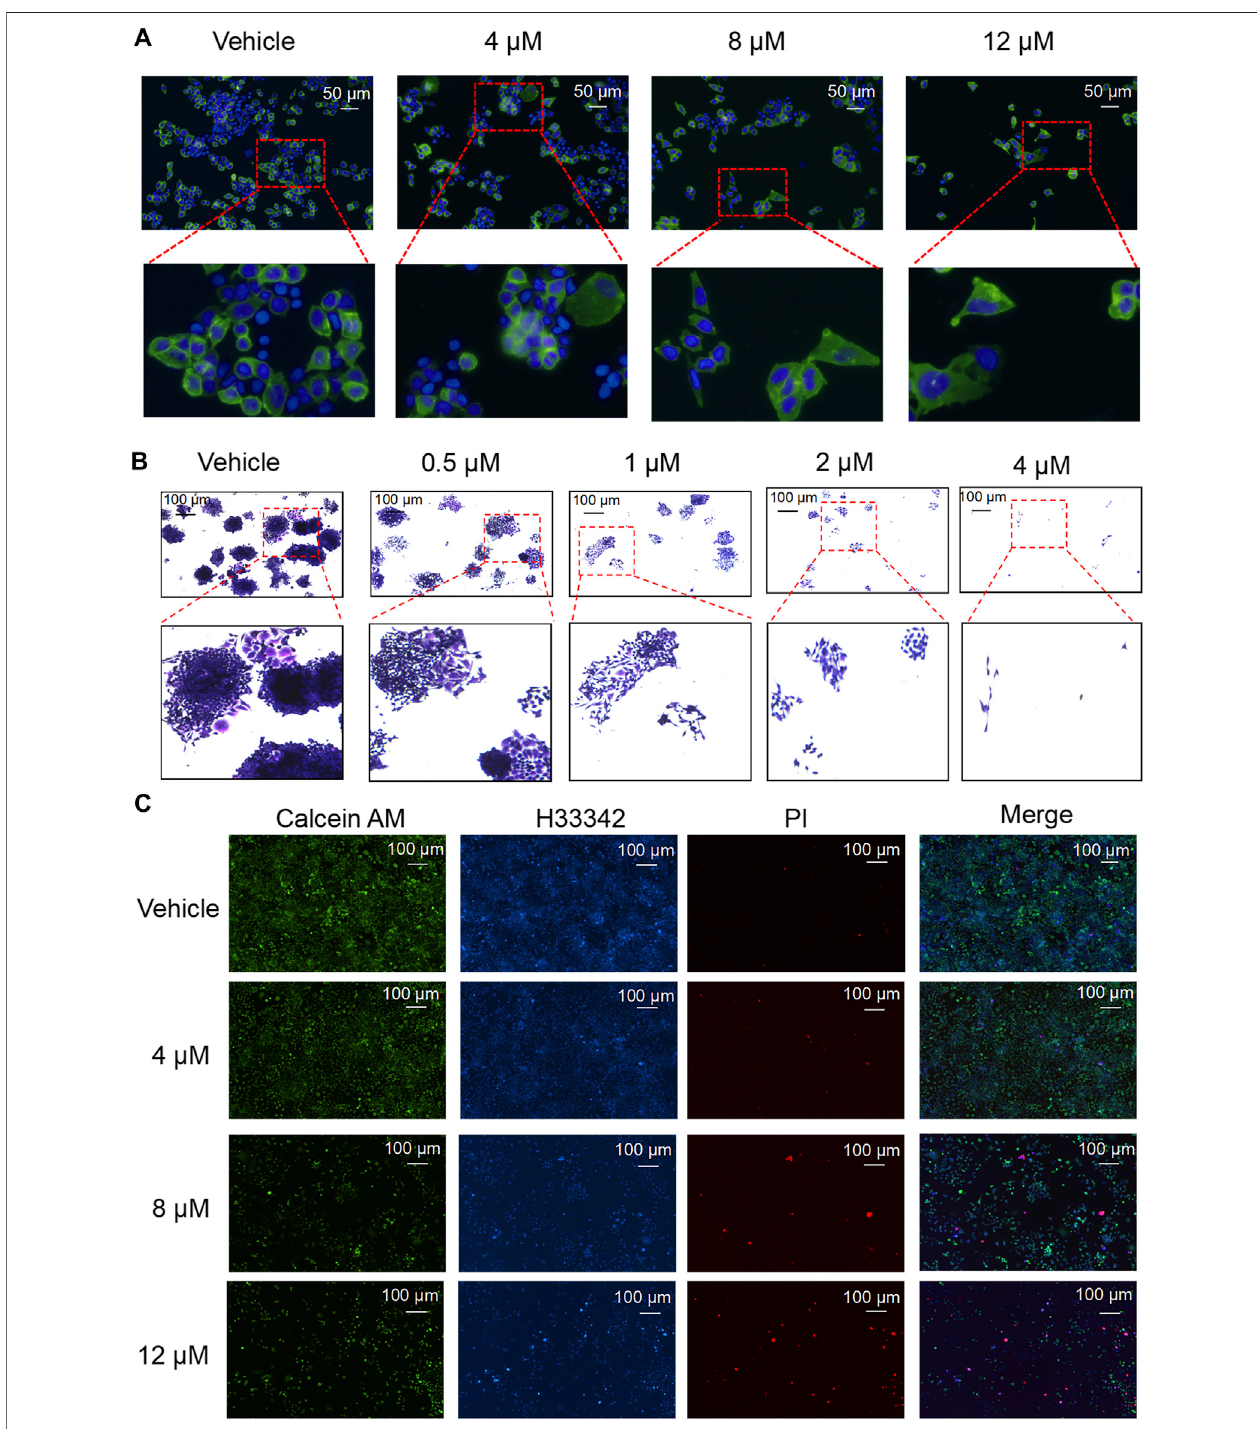
FIGURE2 | Nodosin supressed cellproliferation and triggeredcell death. (A) Nodosin-treated SW480 cells were stained withDio and Hoechst33342 (Dio stained membranes in green and Hoechst 33342 stained nucleus in blue). (B) Different concentrations of nodosin treated SW480 cells for 12 days. Crystal violet stained cell communities were observed with an inverted microscope. (C) Nodosin-treated SW480 cells were stained with Hoechest 33342, Calcein AM and PI. The stained results were recorded by fl uorescence inverted microscope (Hoechest 33342 stained cells in blue, Calcein AM stained cells in green and PI stained cells in red).